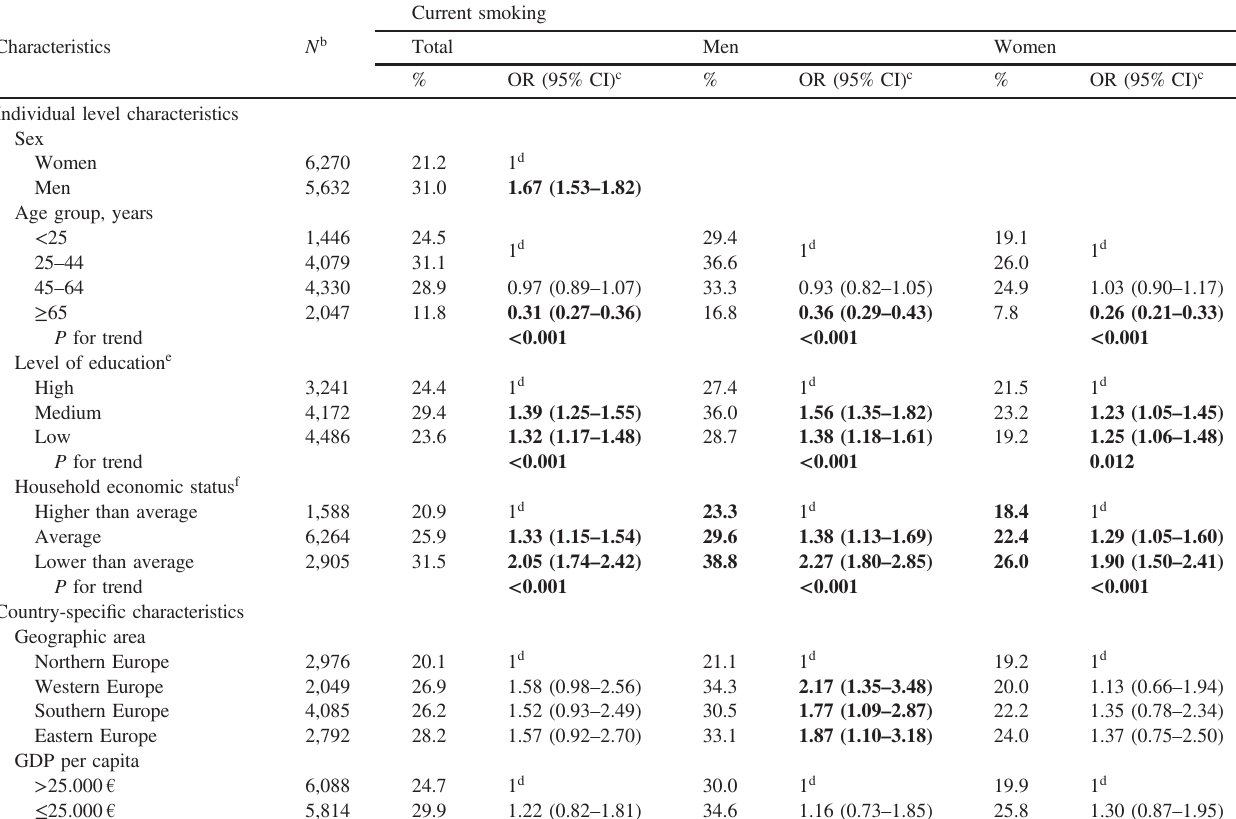
Table 3. OR for current smokers vs non-smokers (never and ex-smokers combined) and corresponding 95% CI in the European population aged ; 15 years, overall and by sex, according to selected individual-level and country-speci fi c characteristics.